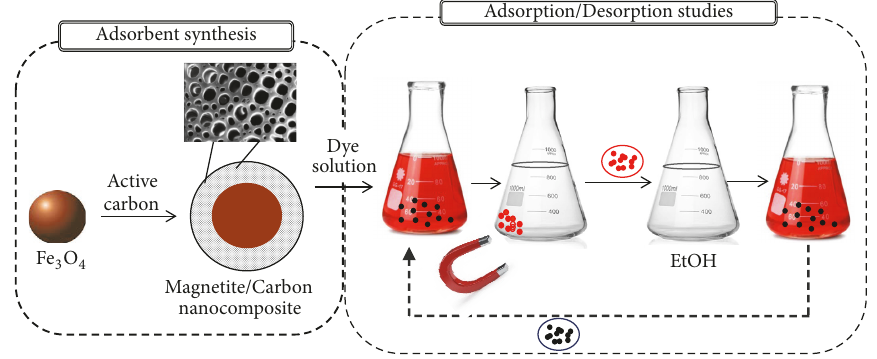
Figure 1: Route of synthesis of MNC and their application for dyes